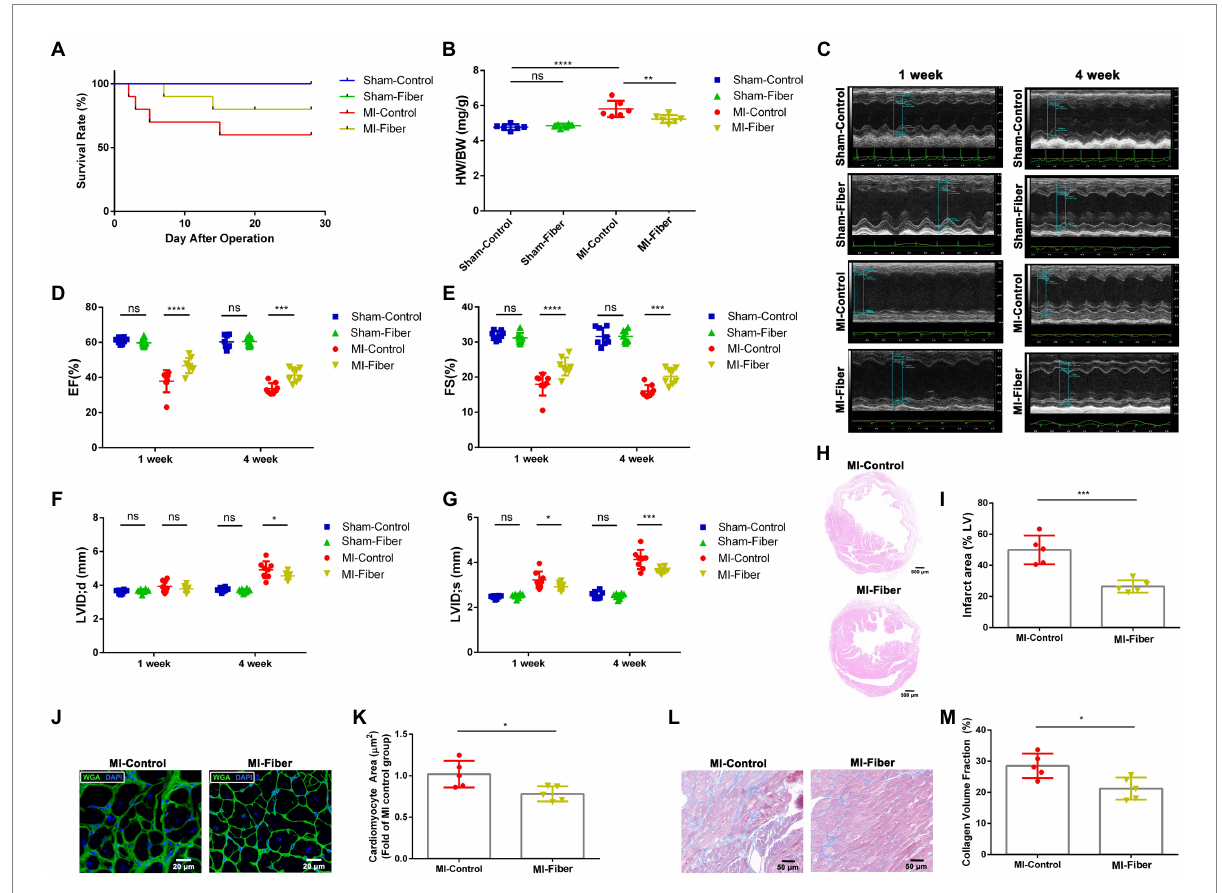
FIGURE 1 High fiber diet alleviates myocardial infarction and left ventricular remodeling in mice. (A) Survival rate of control diet or high fiber diet treated mice after MI. (B) Heart/body weight ratios of sham-control, sham-fiber, MI control and MI fiber mice 4 weeks post operation ( n = 6). (C) Representative echocardiography M-mode images of control diet or high fiber diet treated animals 1 and 4 week following operation. (D , E) Quantitative analysis of EF% (D) and FS% (E) measured by echocardiography 1 and 4 week following MI ( n = 8). (F , G) Quantitative analysis of LVIDd (F) and LVIDs (G) measured by echocardiography 1 and 4 week following MI ( n = 8). (H) Representative images of HE stained heart tissues 4 weeks following MI. Scale bar = 500 μ M. (I) Quantification of infarct area (%) within the ischemic heart in (H) ( n = 5). (J) Representative images of WGA staining of peri-infarct zone 4 weeks post MI. Scale bar = 20 μ M. (K) Quantitative analysis of cardiomyocyte cross-sectional area in (J) ( n = 5). (L) Representative images of Masson’s trichrome stained peri-infarct zone from control diet or high fiber diet mice 4 weeks following MI. Scale bar = 50 μ M. (M) Quantification of interstitial fibrosis by calculating collagen volume fraction in (L) ( n = 5). Graphs depict mean ± SD. * p < 0.05, ** p < 0.01, *** p < 0.001, **** p < 0.0001, ns, not